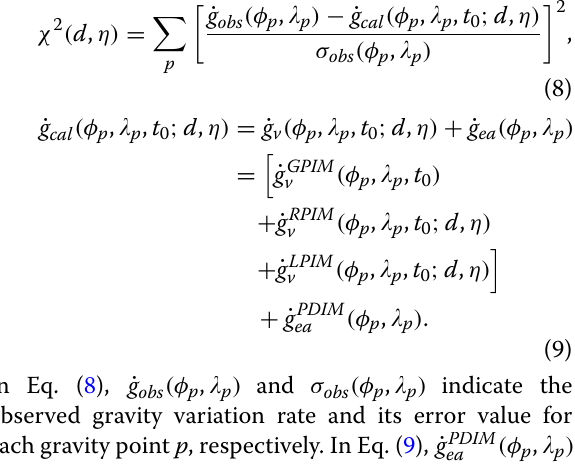
Table 3 Rheological structure defined for RPIM and LPIM Layer Radius [km] Thickness